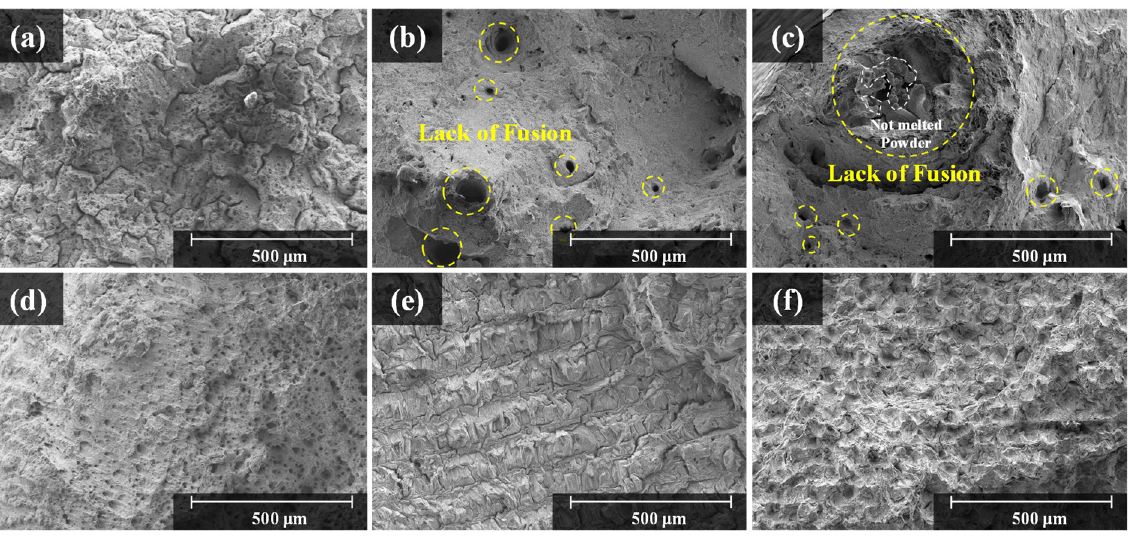
Figure 9. Tensile fracture surface characteristics of the cast and fabricated Hastelloy X specimens with different process parameters: ( a ) cast, ( b ) Powder I as-built, ( c ) Powder II as-built specimens; high-temperature (816 °C) tensile fracture surface characteristics of ( d ) cast, ( e ) Powder I as-built and ( f ) Powder II as-built specimens.